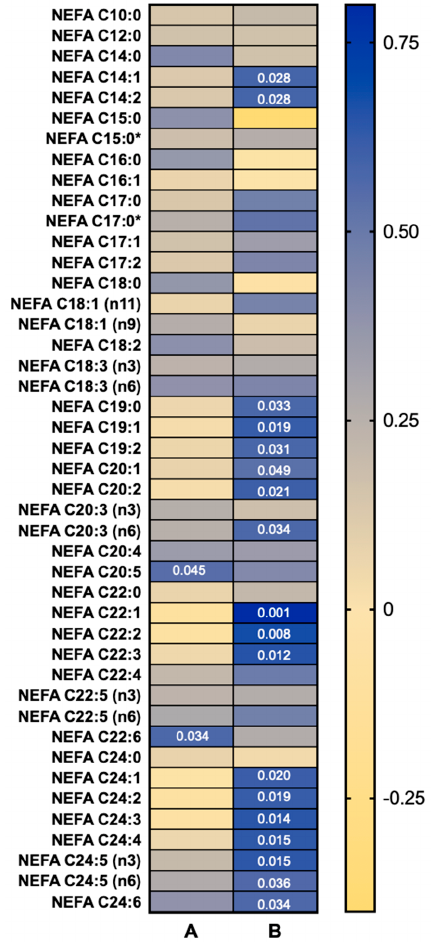
Figure 3. Heat map of Pearson’s r values of correlations between ( A ) plasma non-esterified fatty acid (NEFA) species baseline concentration and ( B ) concentration change after 90 min mild cold exposure against brown adipose tissue (BAT) activity (SUVmean) ( n = 14). Significant correlations ( p < 0.05) indicated by the p values within the heat map. * Indicates branched isomers.